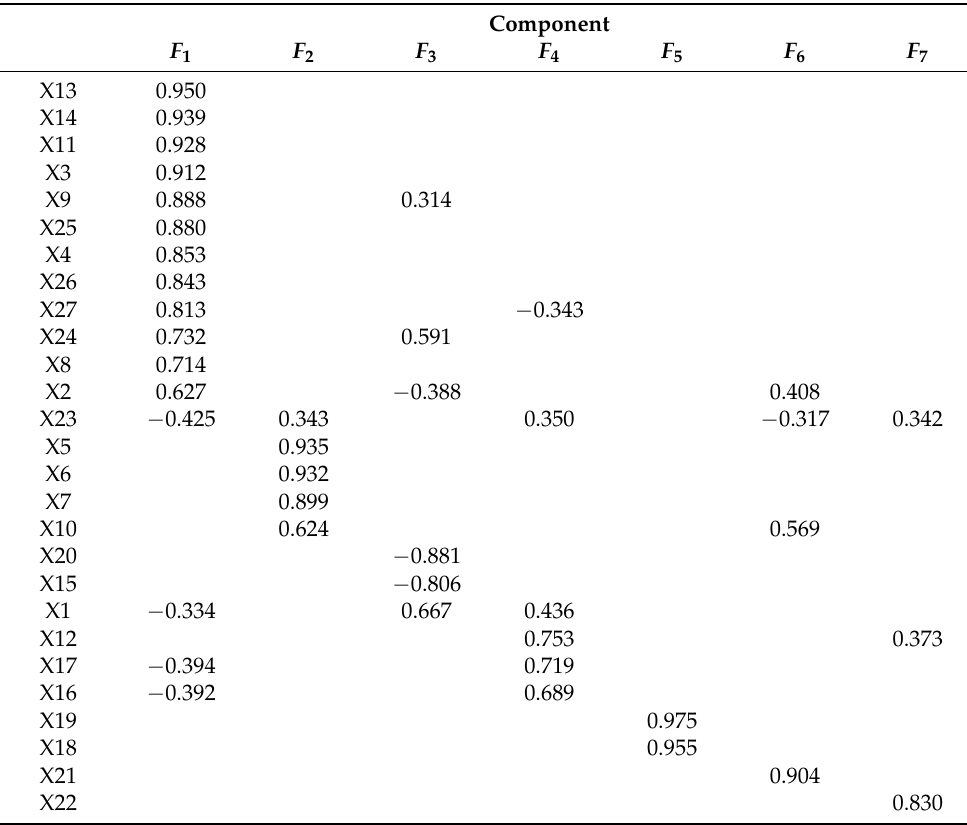
Table 2. Rotated Component